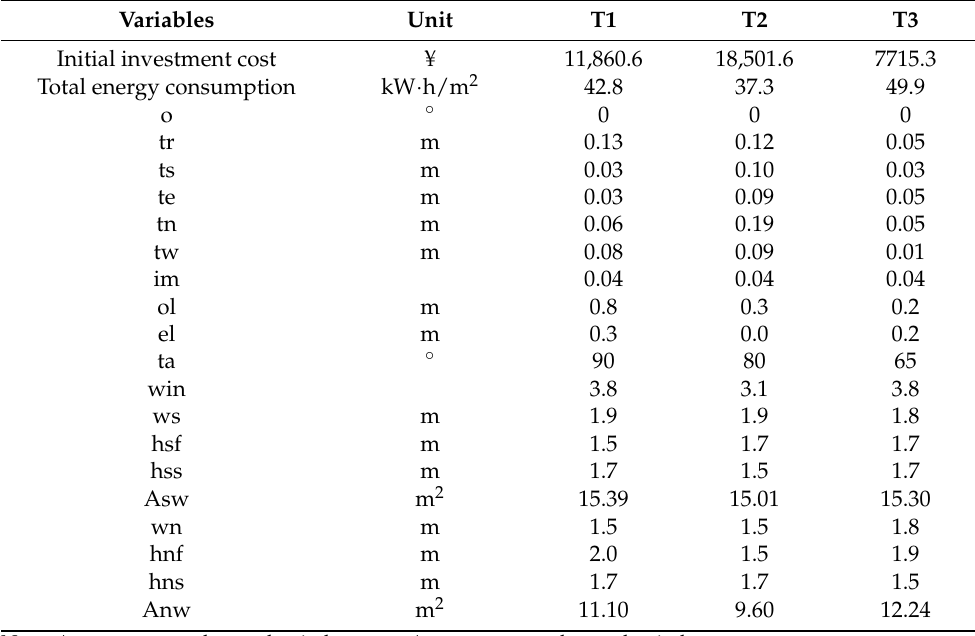
Table 12. Optimum design parameters and corresponding values of objective functions. Variables